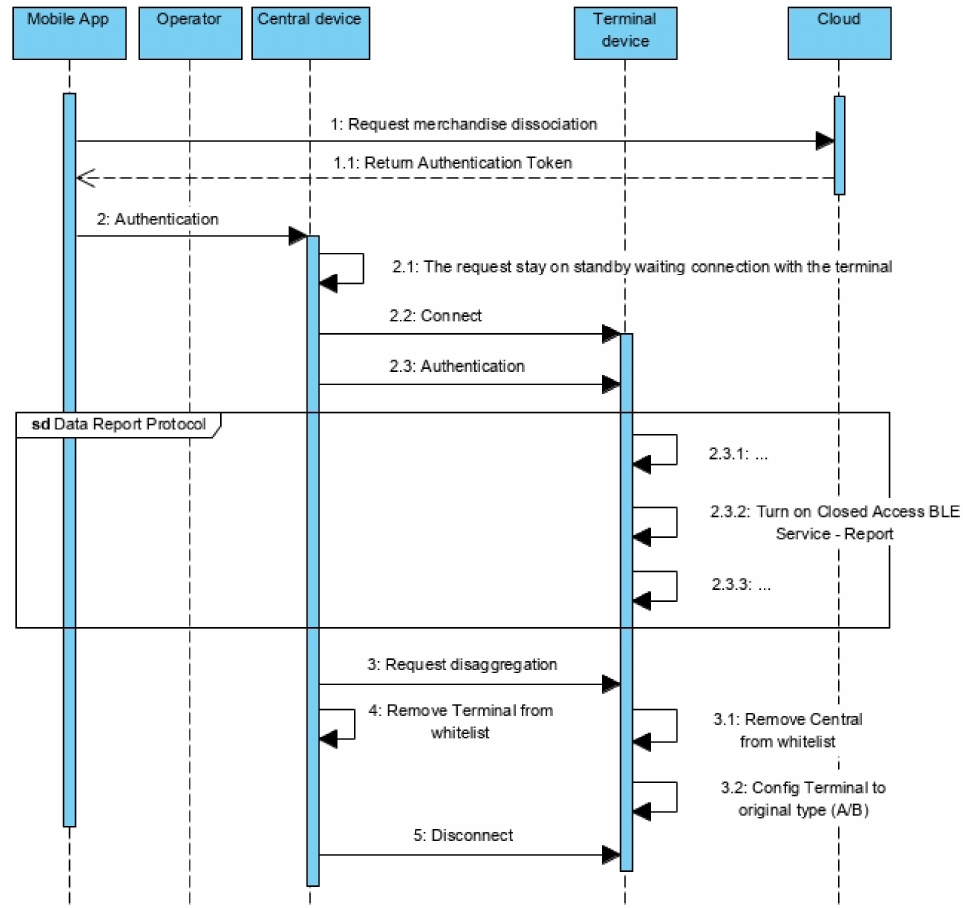
Figure 12. Disaggregation